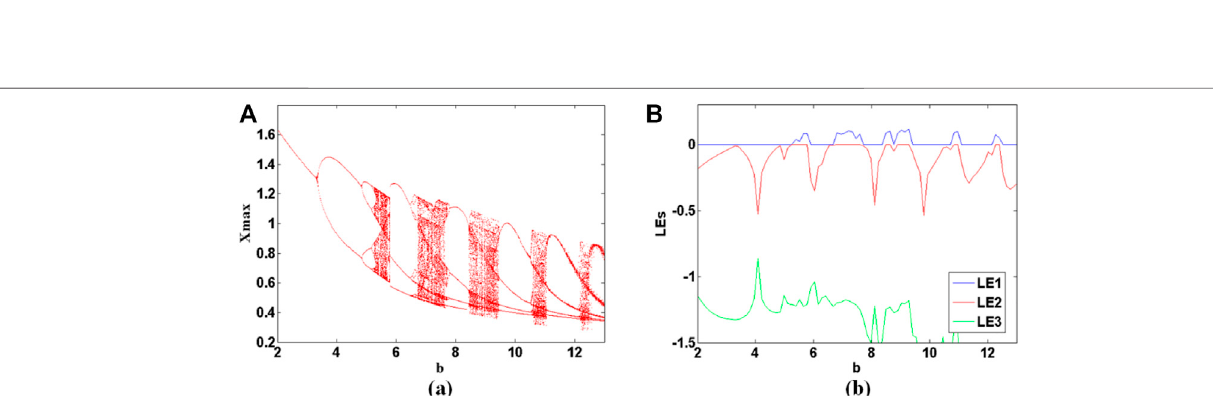
Frontiers in Physics |